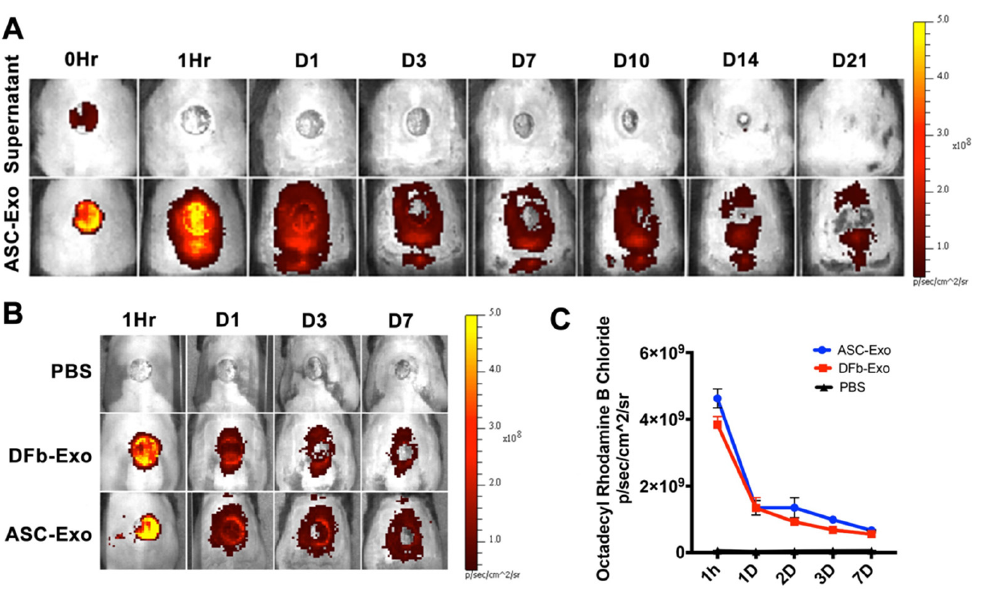
Figure 2. In vivo tracking of exosomes attachment onto wound tissue. ( A ) The bioluminescence distribution of octadecyl rhodamine B chloride (R18)-labeled ASC-Exo during uptake demonstrated strong fluorescent signal within 1 h and showed a time-dependent attenuation till 21 days after treatment. ( B ) The representative images of uptake of ASC-Exo, DFb-Exo, and PBS at wound sites within 7 days post wounding. ( C ) Comparison of fluorescence intensity throughout all groups.